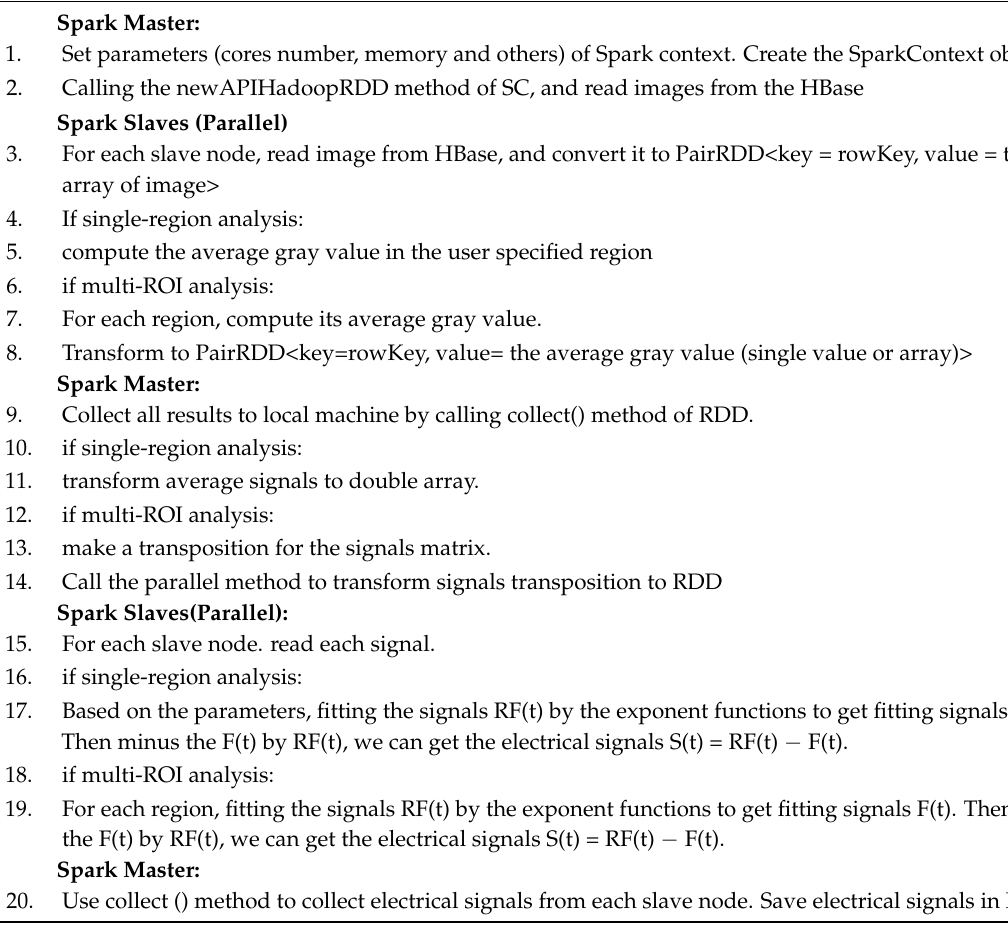
Algorithm 1: Parallel plant electrical signals extraction for fluorescence images datasets based on Spark